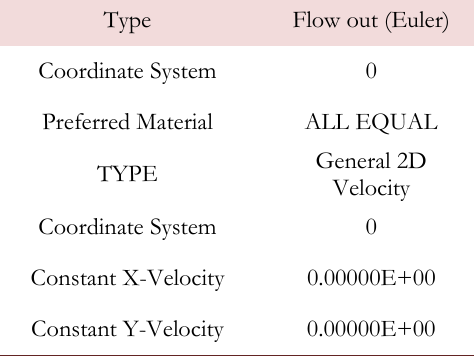
Table 4: Model boundary conditions.